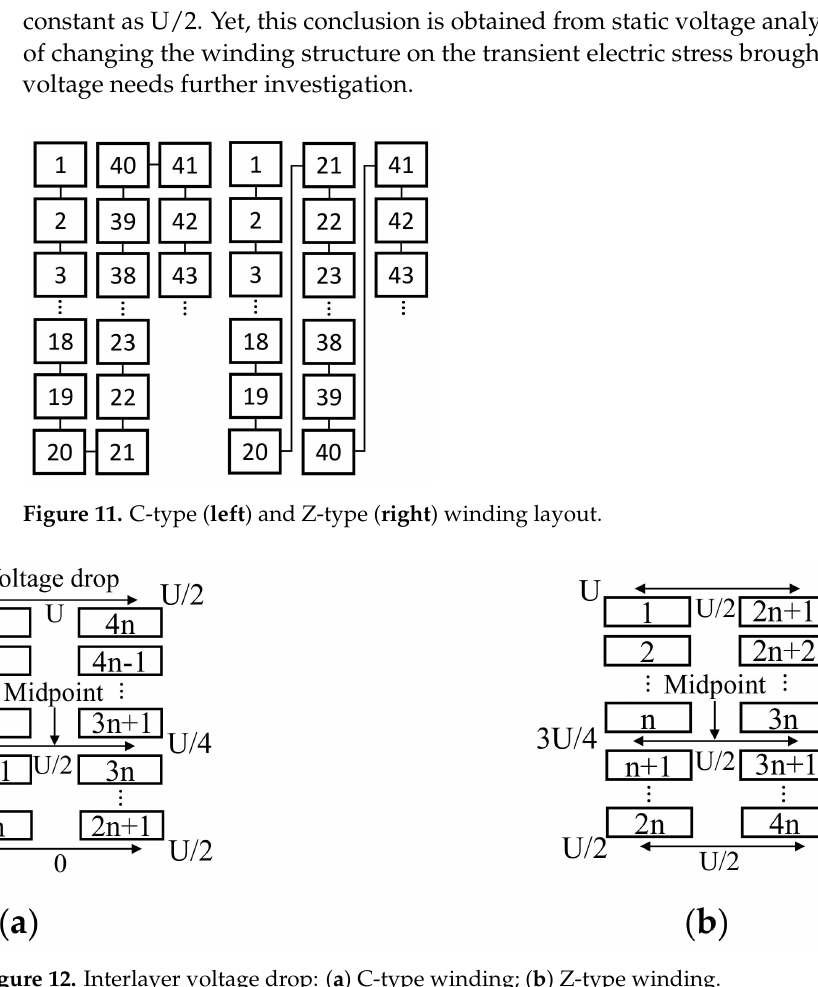
Figure 12. Interlayer voltage drop: ( a ) C-type winding; ( b ) Z-type winding.